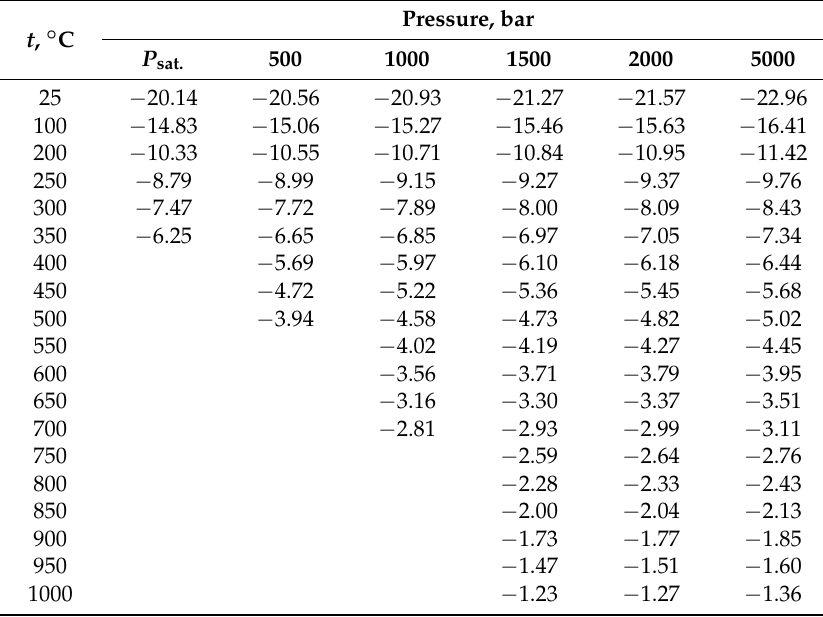
Table 3. The Au solubility constant of the reaction Au (cr) + HCl ◦ (aq) + Cl − = AuCl 2 − + 0.5H 2 ◦ (aq) as a function of temperature and pressure. Calculations were performed using Equation (5) obtained in the present study.